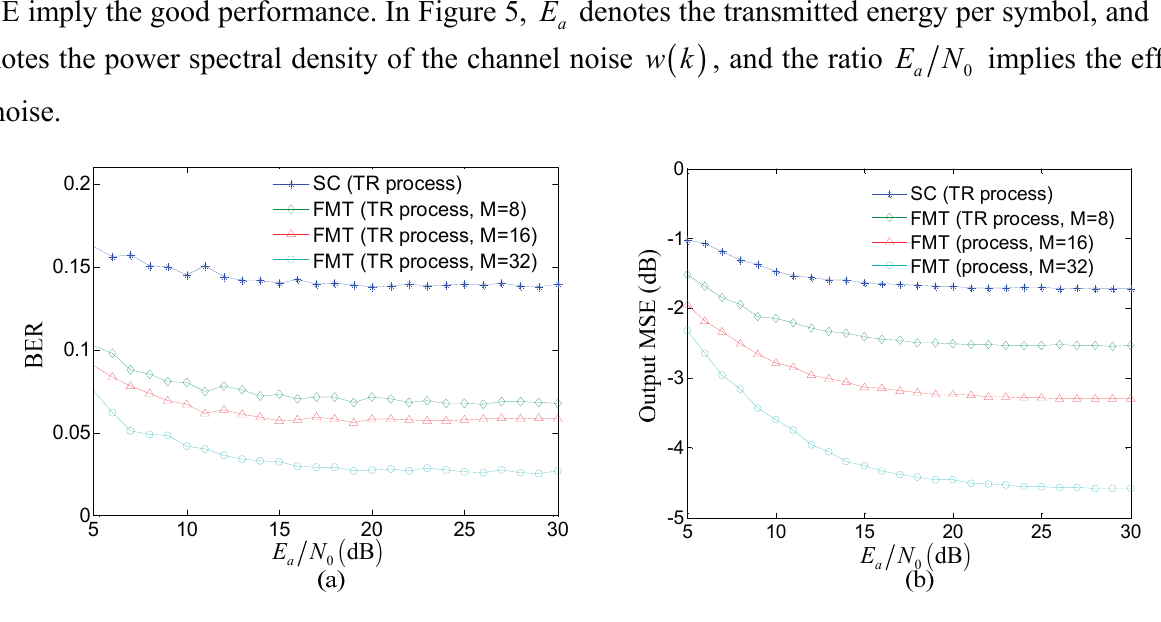
Figure 5. Comparison of the performance of the TR process between the proposed method and the TR acoustic communication using SC modulation: ( a ) BER; and ( b ) output